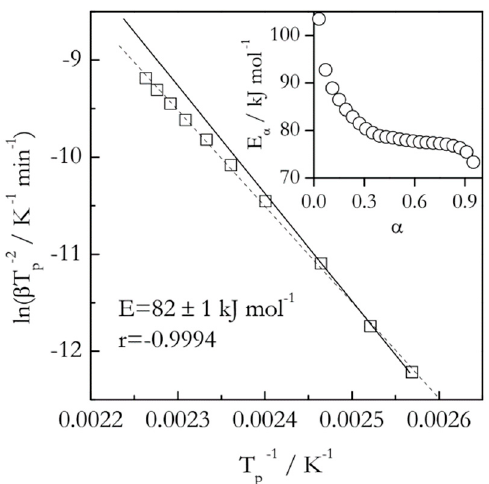
Figure 2. Kissinger plot for thermal dehydration of CaC 2 O 4 H 2 O. Dash line is least square fit to experimental data (squares). Solid line is a fit to the three lower temperature data points. It demonstrates that the angle of the slope changes for higher temperature data. Inset shows variation in isoconversional activation energy. Data from Liavitskaya and Vyazovkin [25].